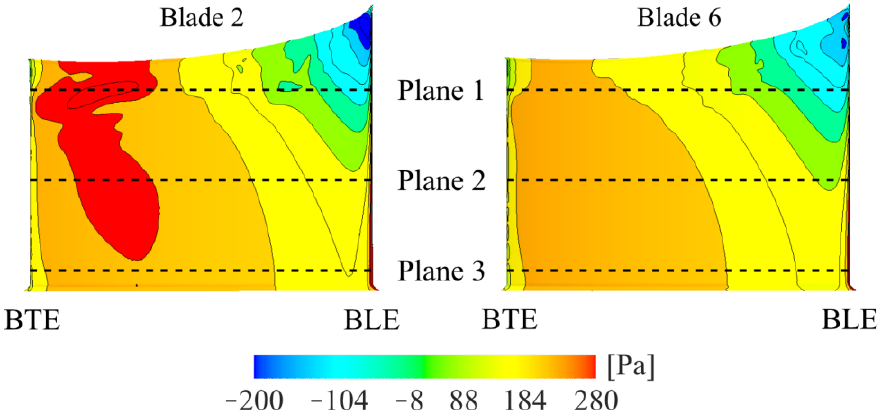
Figure 7. A snapshot of the transient pressure 𝑝 on the surfaces of the pressure sides of Blades 2 and 6. is the sides of the blade trailing edge (BTE) and the blade leading edge (BLE) are marked out.